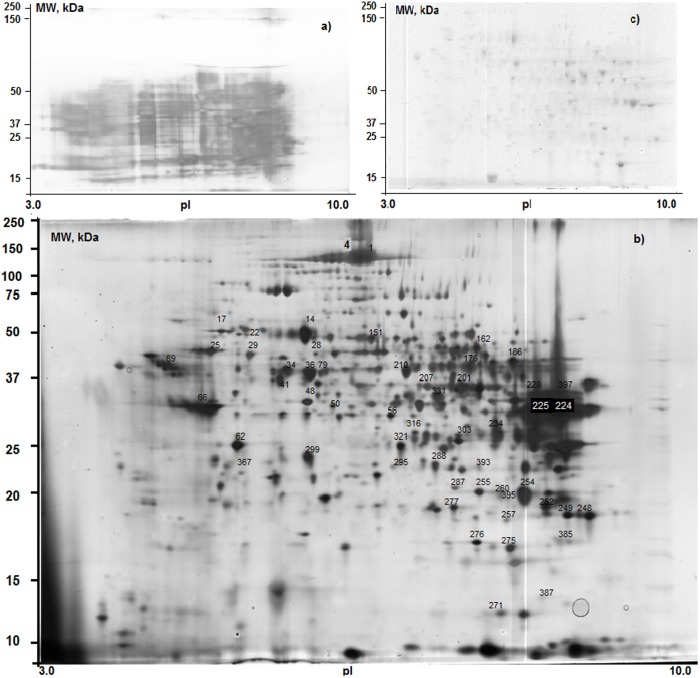
A Typical 2DE images of master gel no.30 µg of the human soluble liver protein fraction (HLC) was separated by 2DE and visualized by silver staining (a and b) or Coomassie Brilliant Blue staining (c): a
 – HLC before pretreatment with trichloroacetic acid in acetone; b and c – HLC after pretreatment. Using Coomassie staining nearly 100 protein spots could be revealed, but using silver staining labeling up to 687 protein spots were automatically detected. Spots nos. 14, 25, 34, 36, 48, 56, 62, 63, 66, 210, 214, 219, 247, 252, 275, 276, 279, 301, 321, 322, and 408 are common for all 2DE gels of 19 human liver cytosol samples.